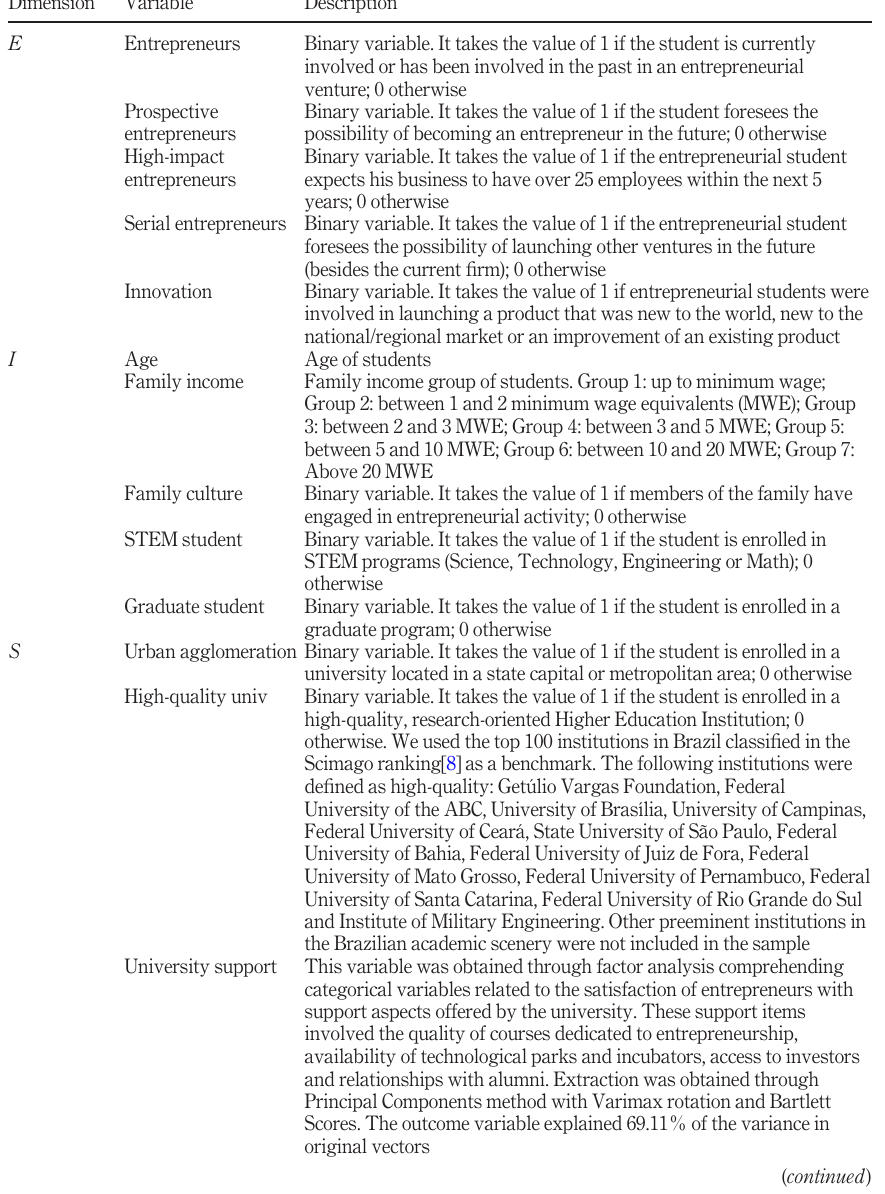
Table I. Variables of